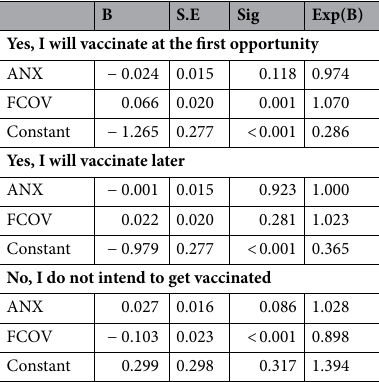
Table 7. Results of binary logistic regression for the sample of prospective healthcare workers (N = 629). ANX sums of GAD-7 scale, FCOV sums of FCV-19S scale, B coefficient for the constant, S. E. standard error, Sig. significance, Exp(B) the odds